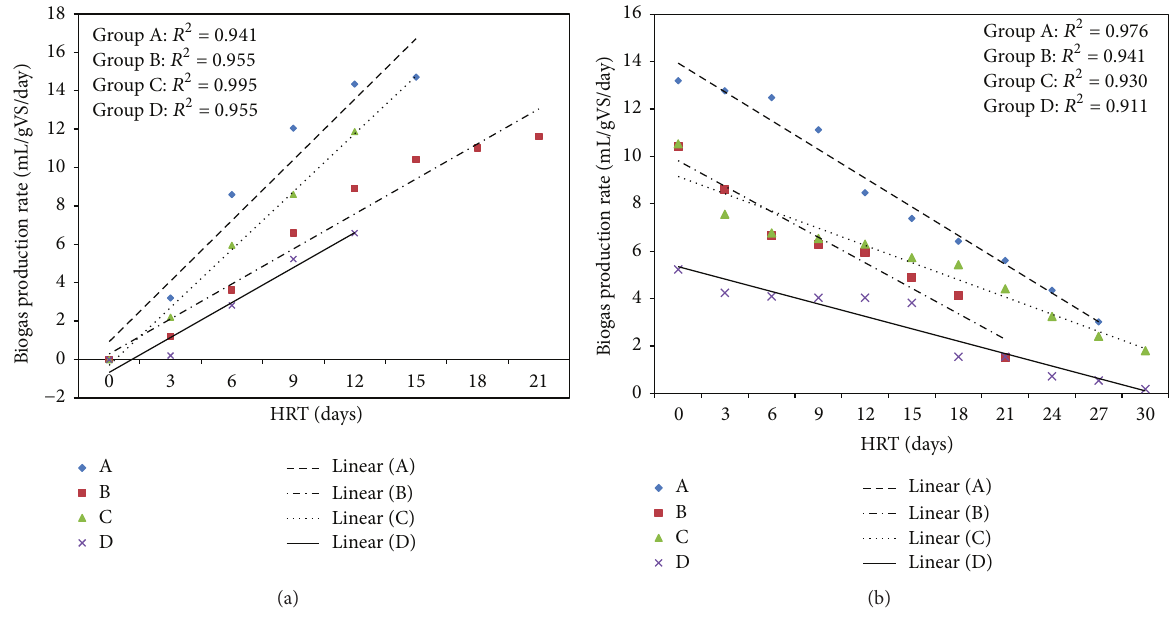
Figure 6: (a) Linear plot of the ascending limb of biogas production rate for thermally treated (groups A and B), untreated (group C) biomass and inoculum (group D). (b) Linear plot of the descending limb of biogas production rate for thermally treated (groups A and B), untreated (group C) biomass and inoculum (group